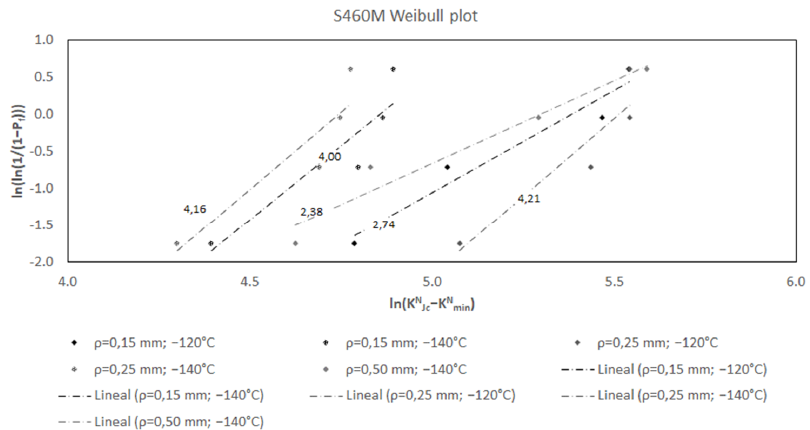
Figure 2. Statistical distribution of K N Jc values determined from the three-parameter Weibull function for steel S355J2.